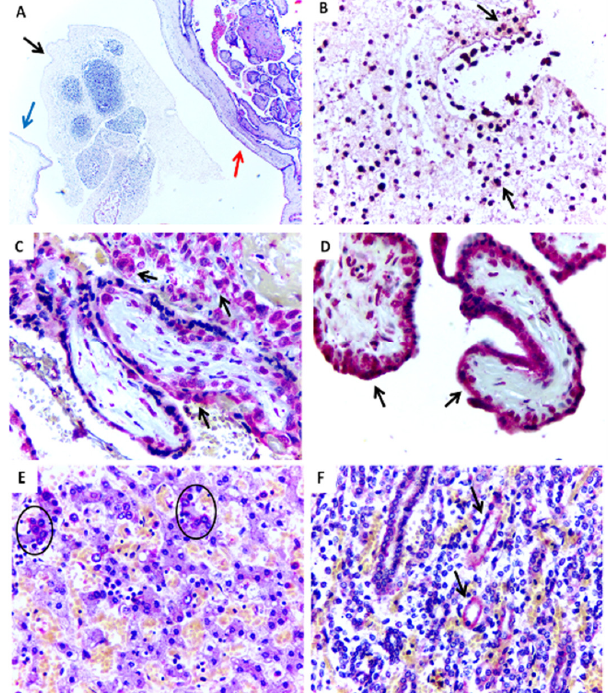
Figure 1. Histopathological aspects and positive immunostaining of the ZIKV-infectedmiscarriage (Case 1). ( A ) Embryonic tissue (black arrow) within the yolk sac (blue arrow) and placenta (red arrow) (HE, 100 × ). ( B ) Positive immunostaining for ZIKV antigens in embryonic tissue (IHC, SAAP, 400 × ). ( C , D ) Positive immunostaining for ZIKV in placental chorionic villi (IHC, SAAP, 400 × ). ( E ) Positive immunostaining to ZIKV observed in the liver in hepatocytes (circle) (Case 3) (IHC, SAAP, 400 × ). ( F ) Positive immunostaining to ZIKV observed in the kidney in renal tubule (black arrows) (Case 3) (IHC, SAAP, 400×).